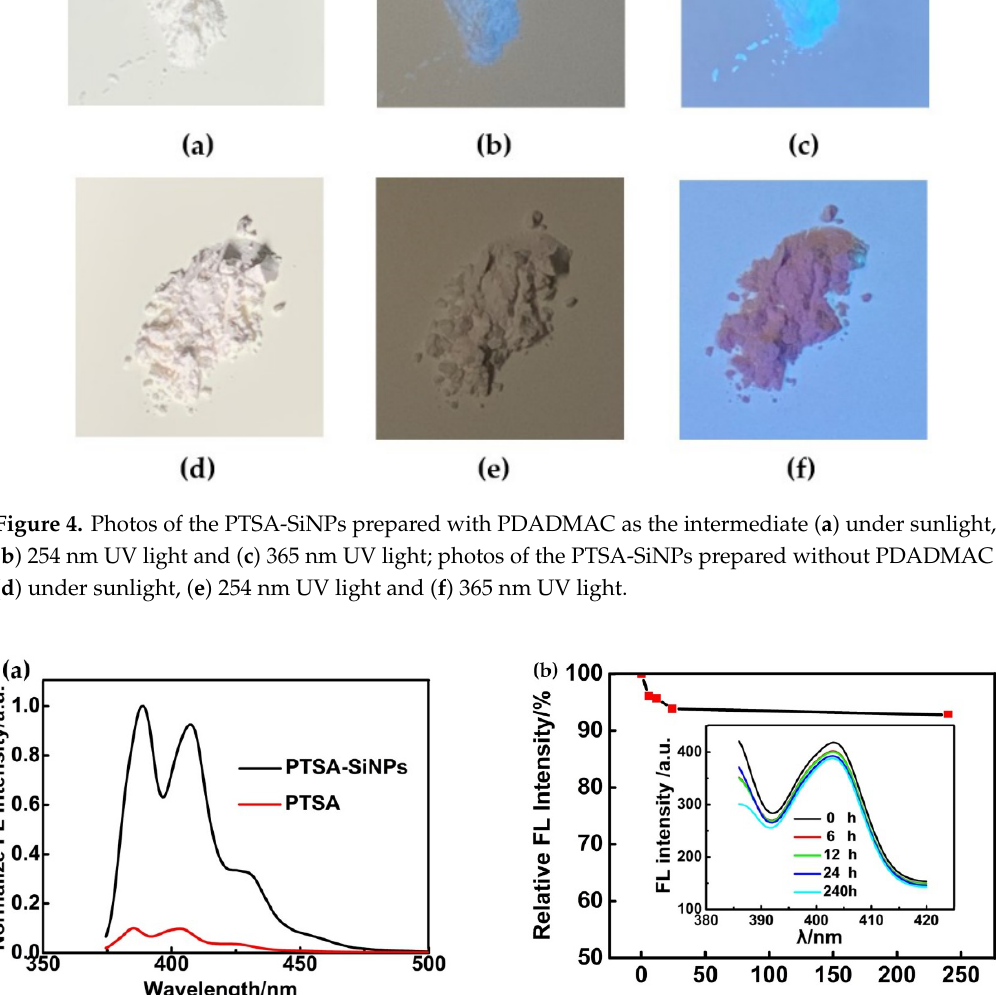
Figure 6. Fluorescence decay curves of PTSA-SiNPs and PTSA in aqueous solution (concentration 10 − 6 M). 3.2. Application of PTSA-SiNPs in Anti-Counterfeit Ink Screen printing is one of the most widely used printing methods. The as-prepared PTSA-SiNPs are applied in the formulation of water-based fluorescent anti-counterfeit ink by screen printing. In Figure 7a,b, it can be seen that the appearance of the PTSA-SiNPs prepared ink is a milky white liquid under sunlight, and a blue fluorescence emulsion under UV light. The structure system of the PTSA- SiNP ink remains stable, without sedimentation, flocculation or stratification. The main reason is that the as-synthesized PTSA-SiNPs has good water compatibility and particle size uniformity, which is conducive to the stable existence of particles in the water emulsion dispersion system. The pattern of the ink printed on the paper is not visible under sunlight, but is clearly visible under UV light (Figure